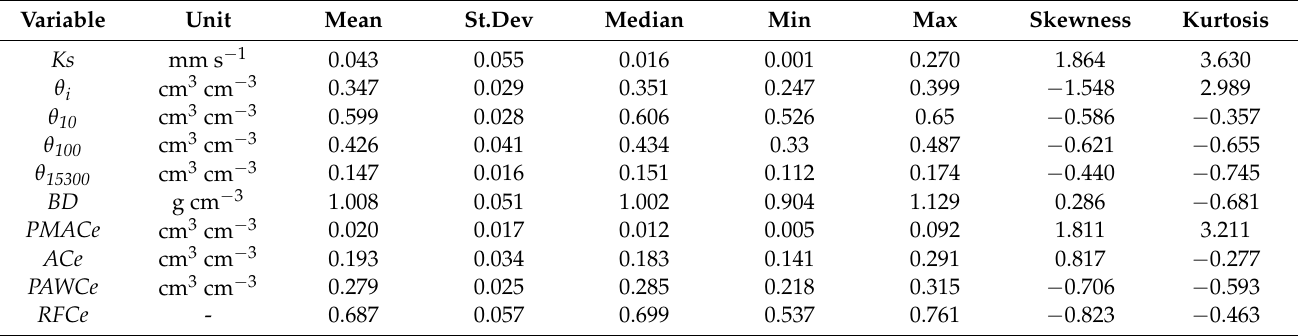
Table 1. Summary statistics for the variables under